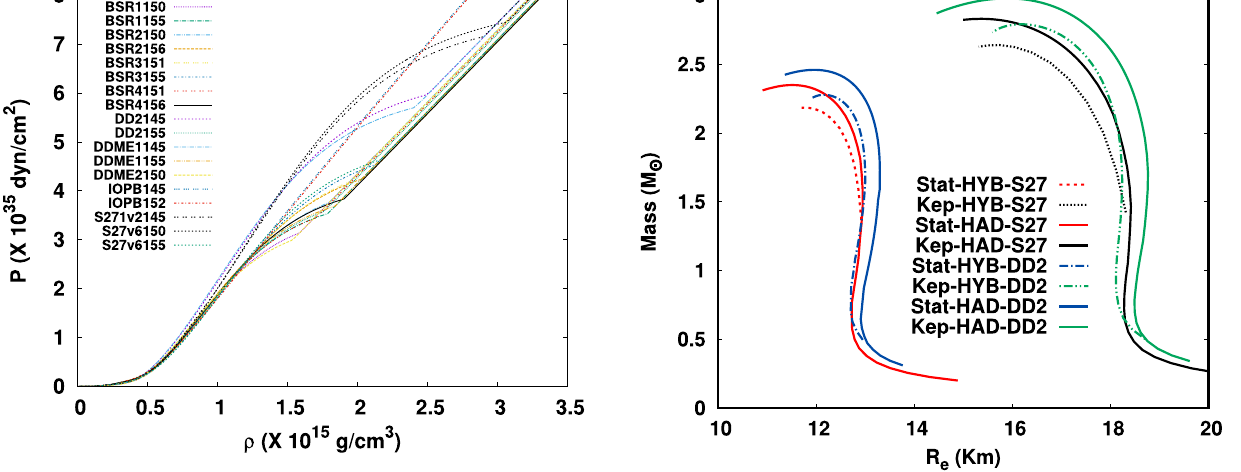
Fig. 2 M − R has been plotted for S27 EoS. The Plot shows two main clusters, the static model (Stat) and Keplerian model (Kep), where each of the models has hadronic (HAD) and Hybrid (HYB) EoS. The maxi- mum mass and its corresponding radius and central density are obtained from the Plot. The hadronic EoS supports more massive stars than the quark EoS (as the EoS is